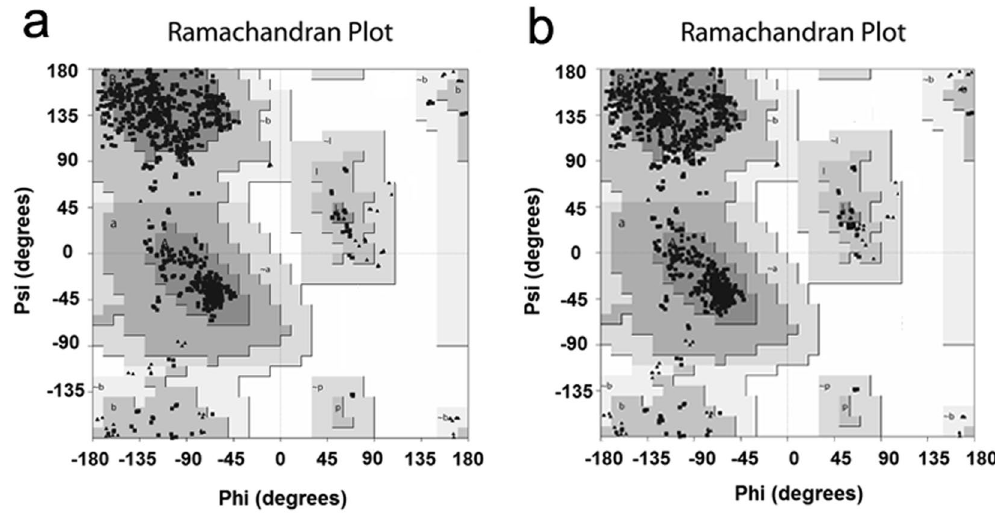
Figure 1. Ramachandran plot of modeled HA. ( a ) A/Washington/10/2008(H1N1) HA. ( b ) A/ Florida/21/2008(H1N1)